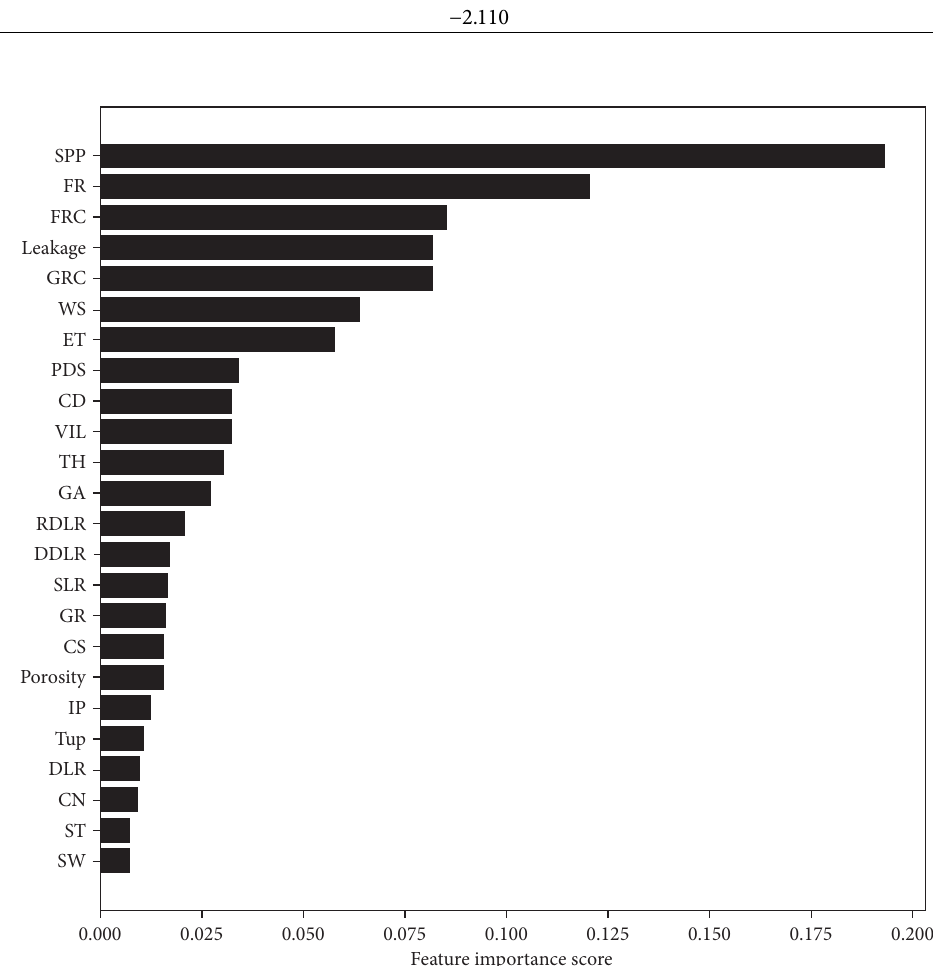
Figure 3: Random forest feature importance